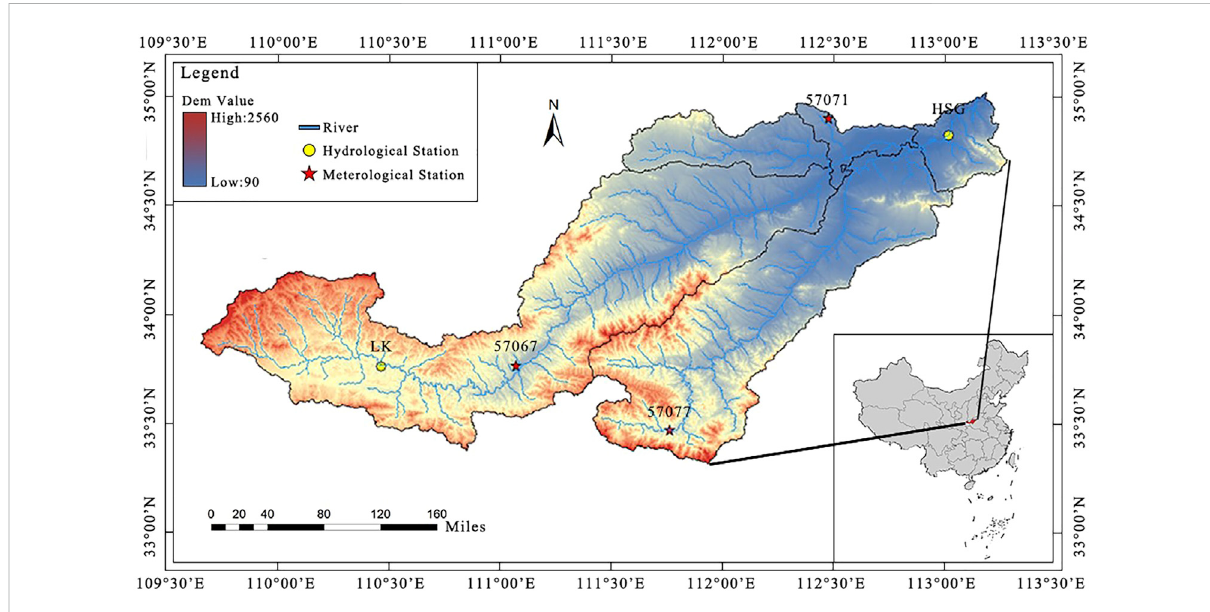
FIGURE 1 General situation of the Yiluo river basin and location of hydrological and meteorological